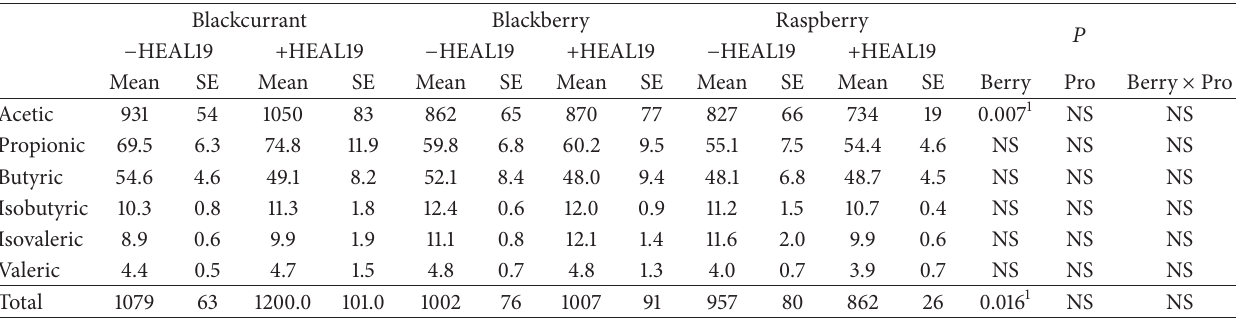
Table 5: Levels of short-chain fatty acids ( 𝜇 mol/L) in portal serum of rats fed diets containing blackcurrant, blackberry, and raspberry, with the same diets supplemented with L. plantarum HEAL19. Blackcurrant Blackberry Raspberry 𝑃 − HEAL19 +HEAL19 − HEAL19